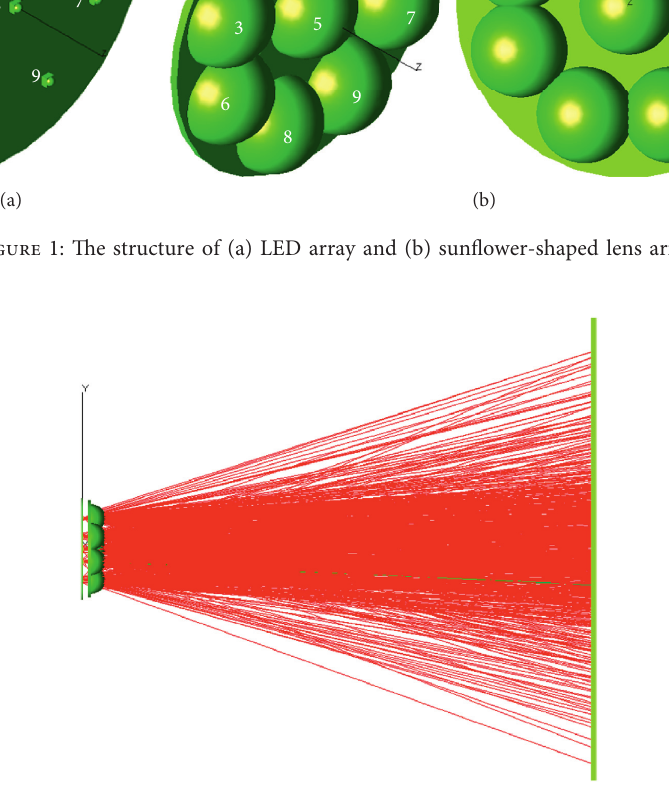
Figure 2: The effect diagram obtained by ray tracing the sunflower-shaped lens array.